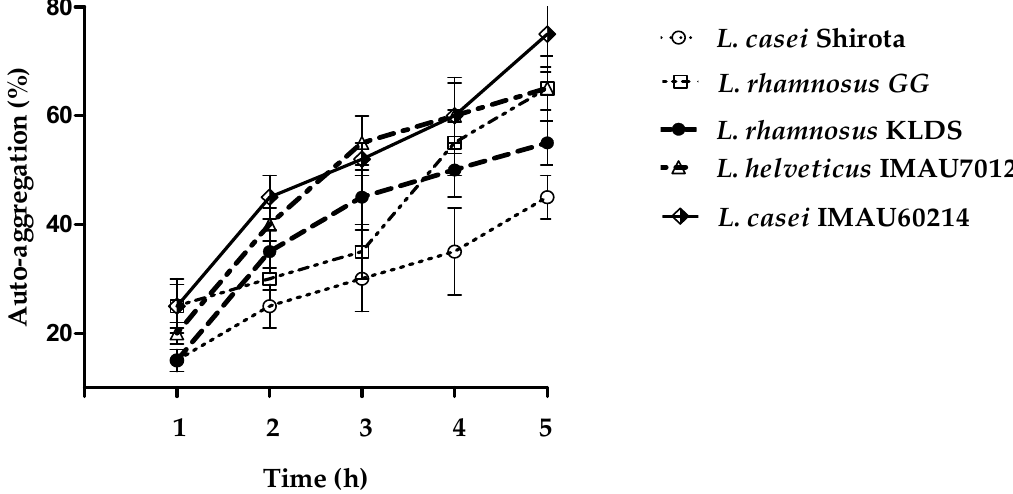
Figure 2. Auto-aggregation of Lactobacillus strains as determined after various times of incubation durations at 37 °C. The values represent the mean value ± standard deviation (SD) of three different assays.